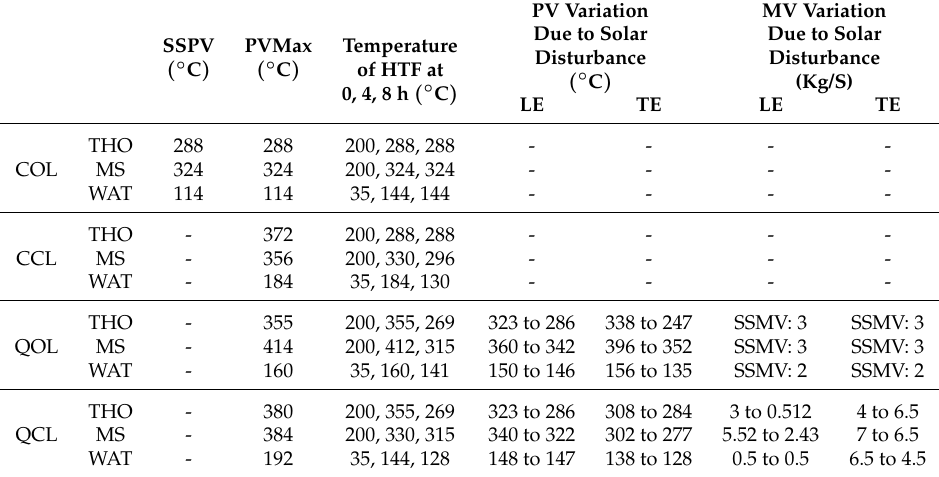
Table 7. Control parameters performance for case studies. (Abbreviations used in this table are: THO = Therminol oil, MS = Molten salt, WAT = Water, LE = Leading edge at 2 h, TE = Trailing edge at 6 h, PV: Process variable, MV = Manipulated variable, SSPV = Steady State value of PV, SSMV = Steady State value of MV, PV MAX = Maximum value of